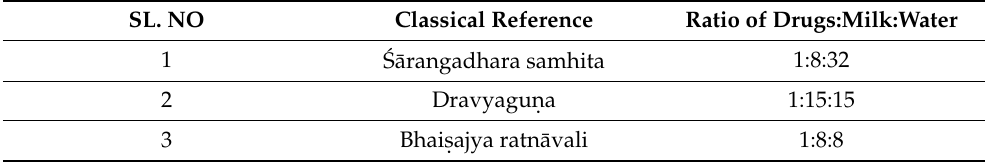
Table 1. Ratio of ingredients. SL. NO Classical Reference Ratio of